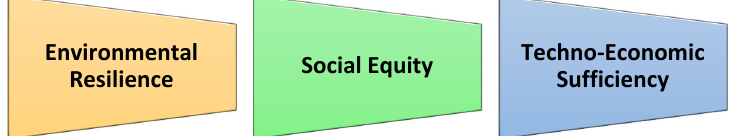
Figure 2. Inclusivity of development.